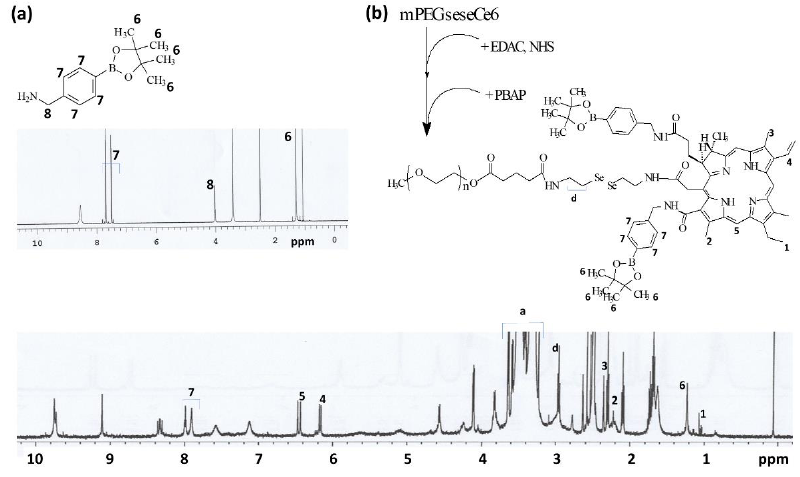
Figure 2. Chemical structure, synthesis scheme and 1 H NMR spectra of PBAP ( a ) and mPEGseseCe6PBAP conjugates ( b ). Table 1. Particle size and Ce6 contents in the nanophotosensitizers.